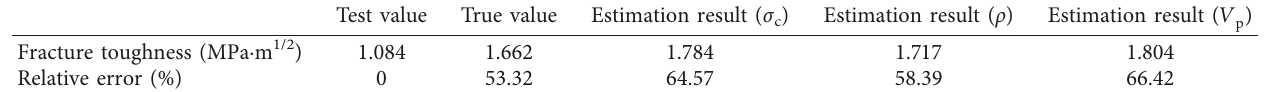
Table 4: Comparison of the results of this study with the estimation